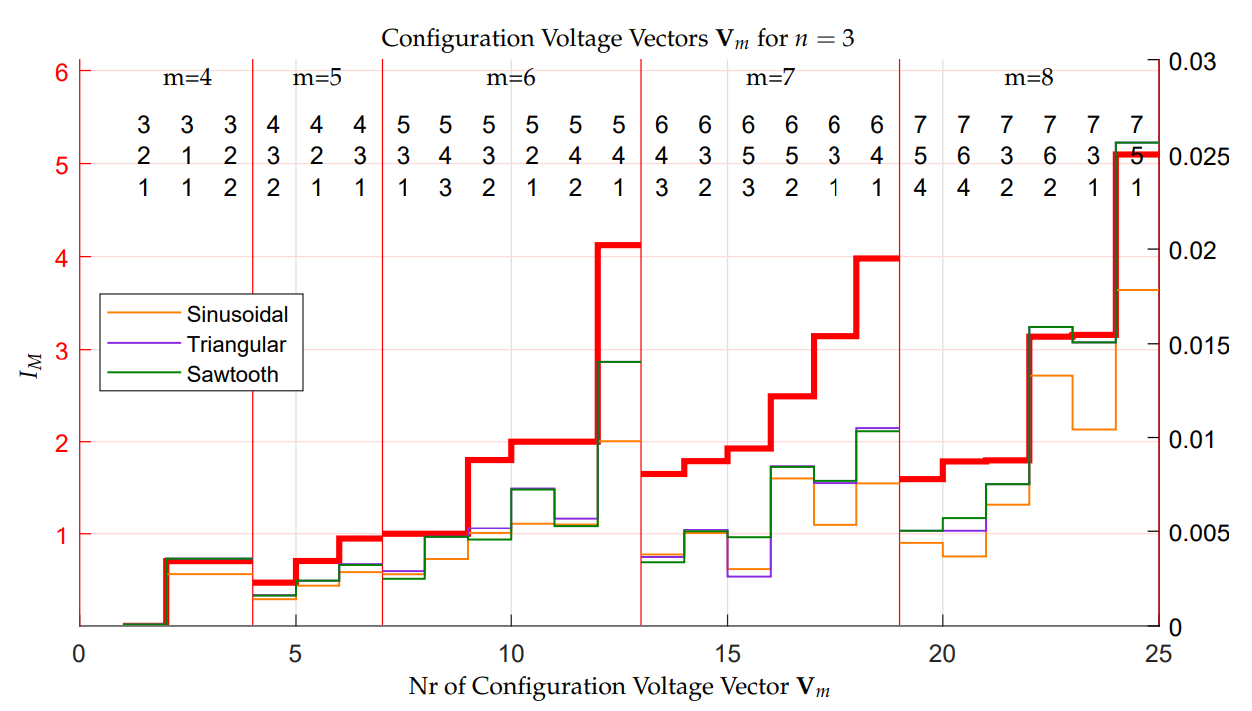
Figure 20. Comparison between the Divergence Index I M and metric max ( ∆ V ) , computed from simulation using three different ˜ V d signals, for the Configuration Voltage Vectors V m in the case n =